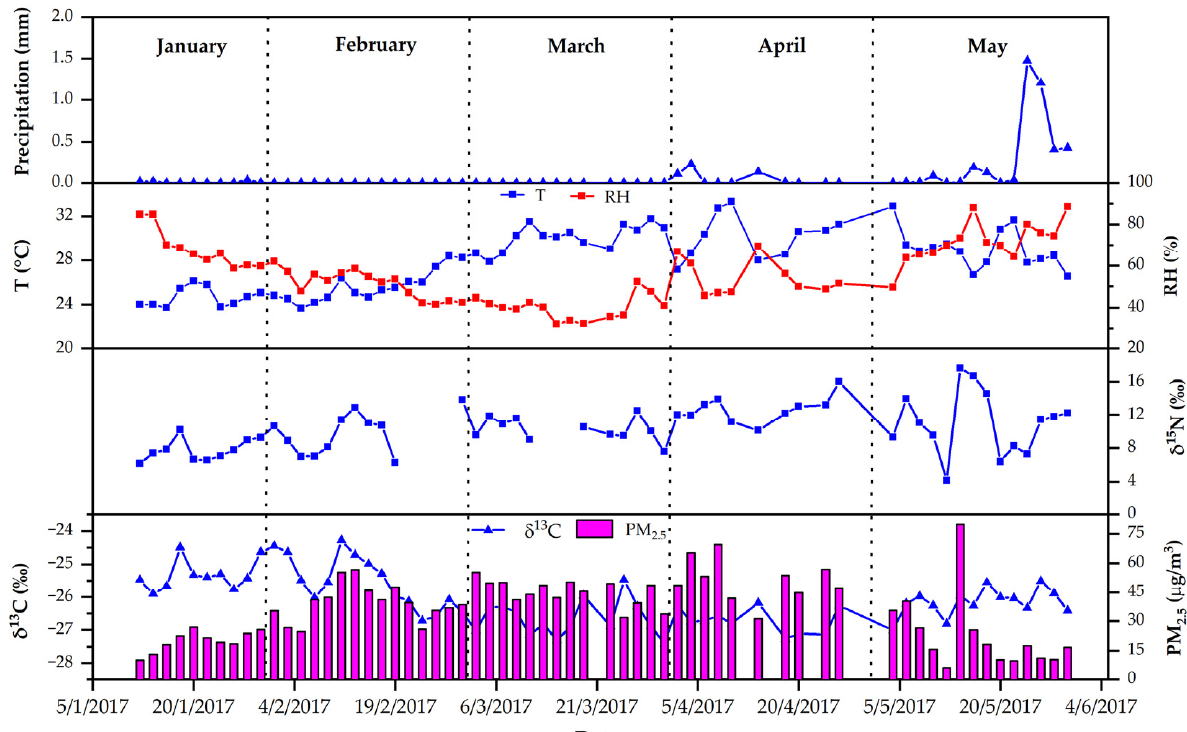
Figure 2. Temporal variation in stable isotopic and meteorological parameters during the sampling period in Chiang Mai city.